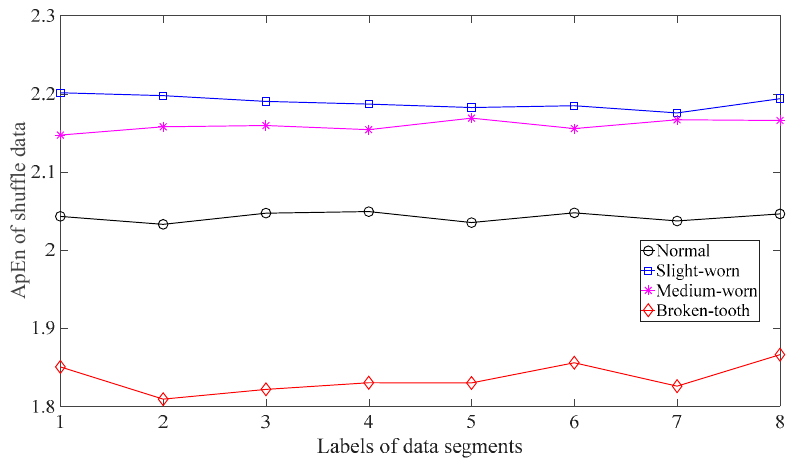
Figure 7. ApEn of the shuffle versions of the four types of gear vibration data.